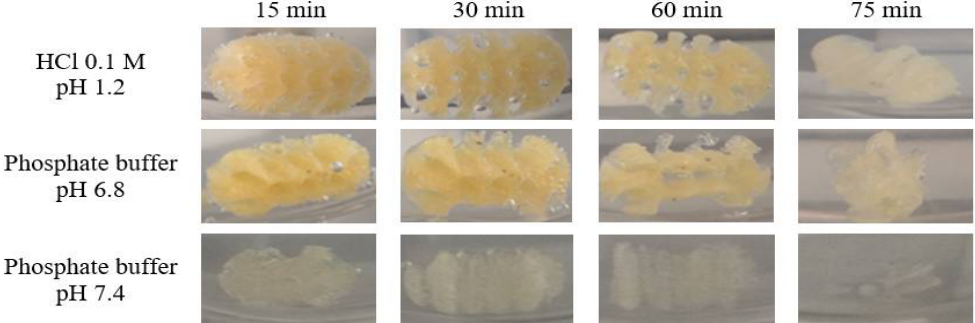
Figure 7. Depictions of KET-loaded FDM 3D printed channeled tablets throughout dissolution in HCl pH 1.2, phosphate buffer pH 6.8, phosphate buffer pH 7.4.